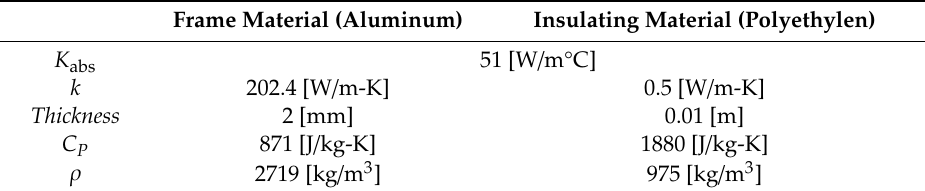
Table 1. PVT air material information.